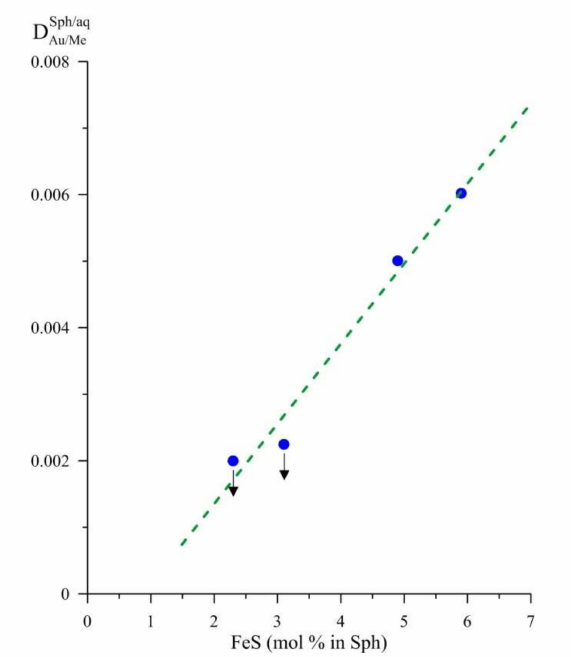
Figure 2. Au / Me (Me = Zn + Fe) cocrystallization coe ffi cient as a function of sphalerite composition.